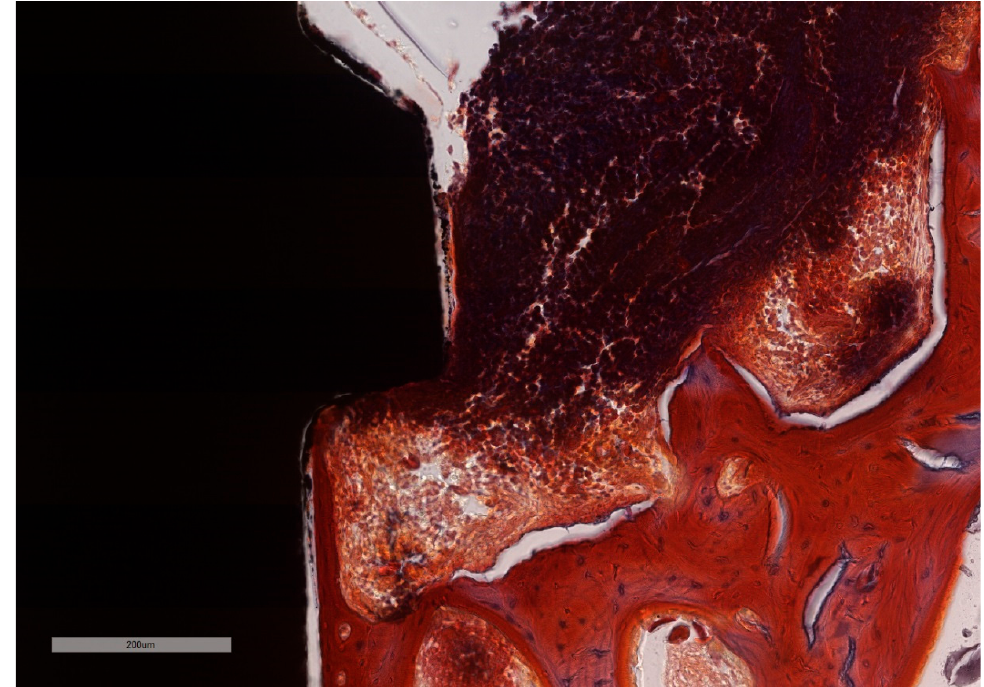
Figure 11. Bone in active phase of remodeling. ICT in simultaneous contact with the bone and with the implant surface with no squamous epithelium covering. Additionally, active bone remodeling is identified by the scalloped endosteal surface (Howship’s lacunae) (implant #1, MGA, bar measure is 200 µm).